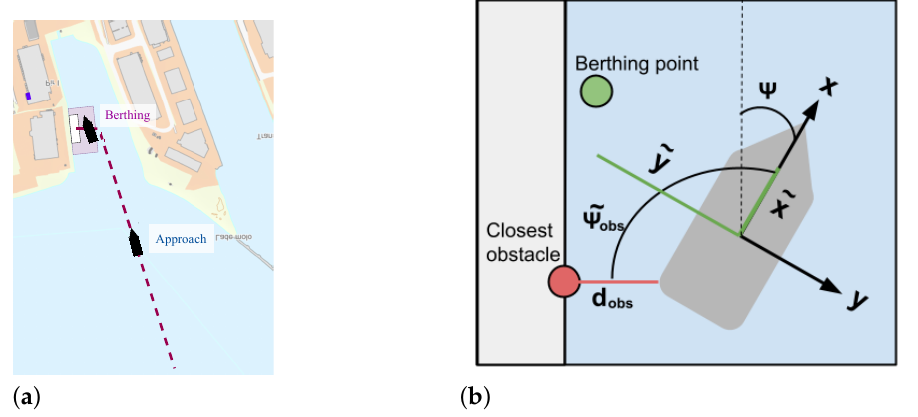
Figure 1. ( a ) The simulation environment, and ( b ) an illustration of the vessel’s